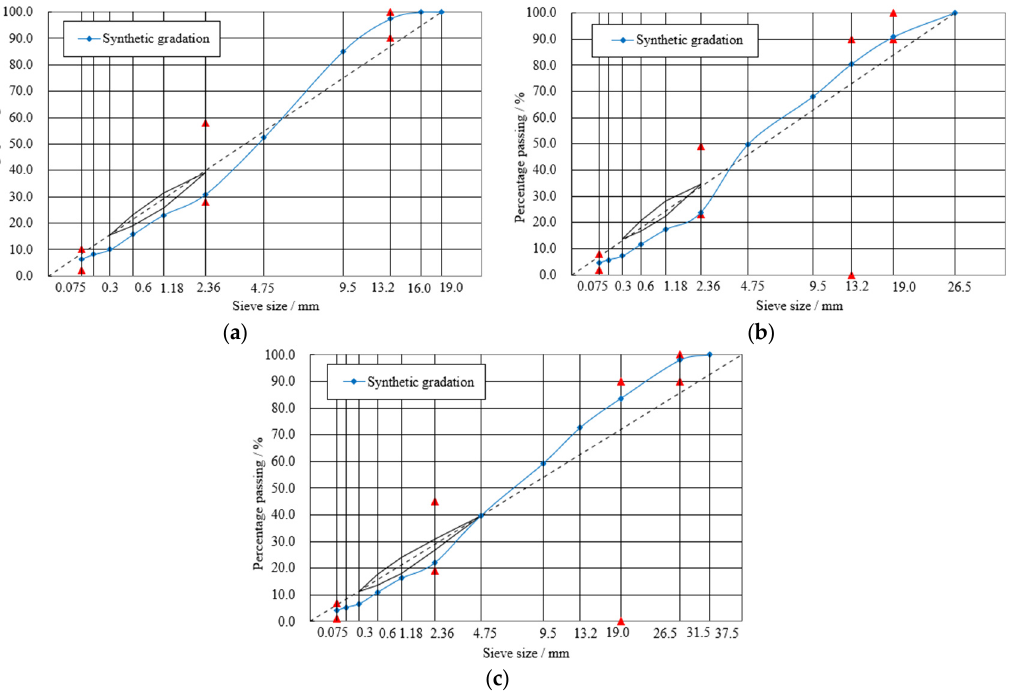
Figure 1. Mixture gradation curves: ( a ) SUP-13; ( b ) SUP-20; and ( c ) SUP-25.